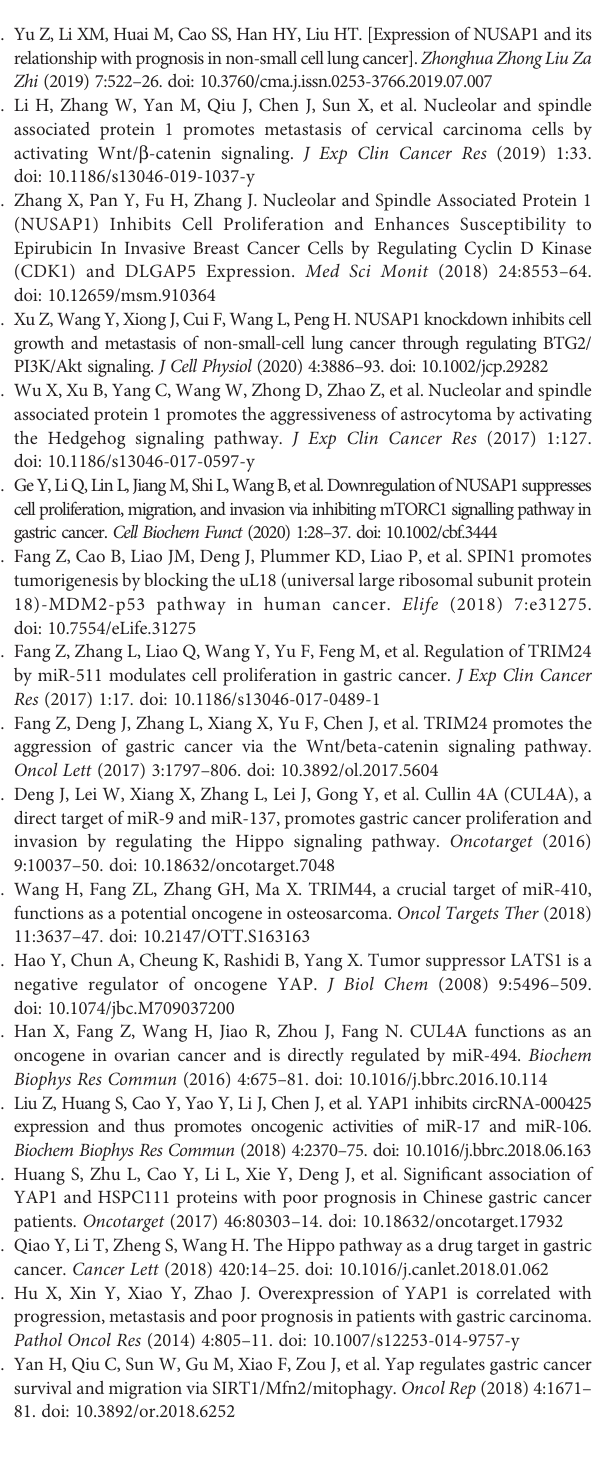
SUPPLEMENTARY FIGURE 3 | NUSAP1 regulates cell proliferation, migration, and invasion of GC cells in vitro . (A) SGC7901 and MGC803 cells were transfected with Flag-NUSAP1 or NUSAP1 shRNAs, and the transfection ef fi ciency was detected by Western blotting. (B, C) Representative images of colony-formation assays for modi fi ed SGC7901 and MGC803 cells. Cells were fi xed and stained, the colonies were counted, and the data are represented in the bar graph. (D) Cell viability was analyzed by CCK-8 assay. (E, F) Representative images of fi xed and